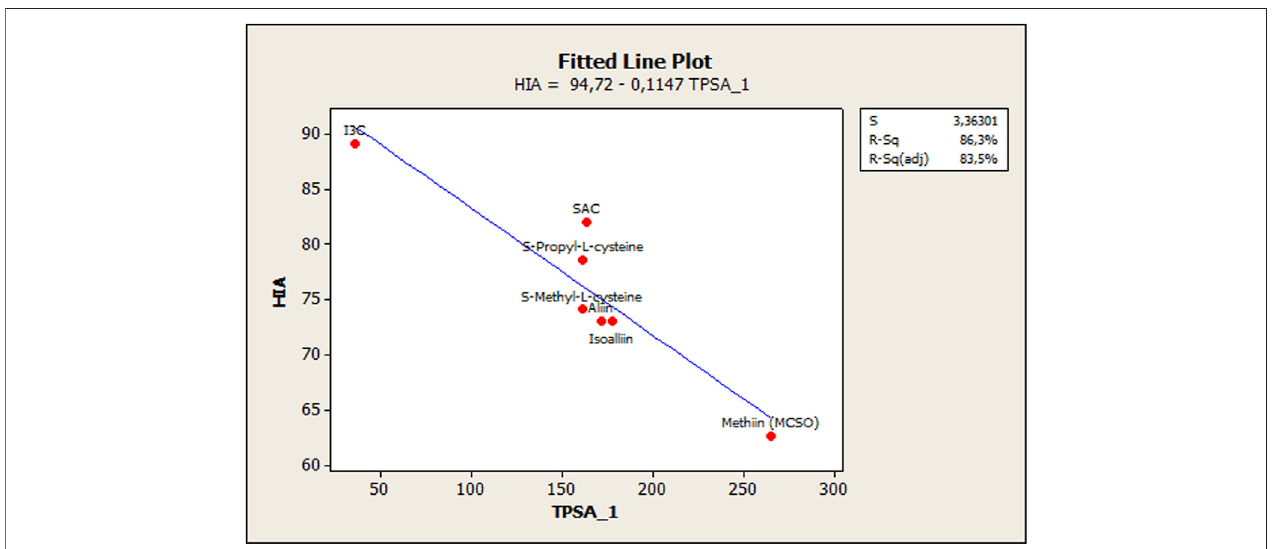
FIGURE 4 | Scatterplot of ionizable OSCs showing the relationship in Figure 6 . The relationship between actual and calculated log KP skin permeability values using the PLS approach.